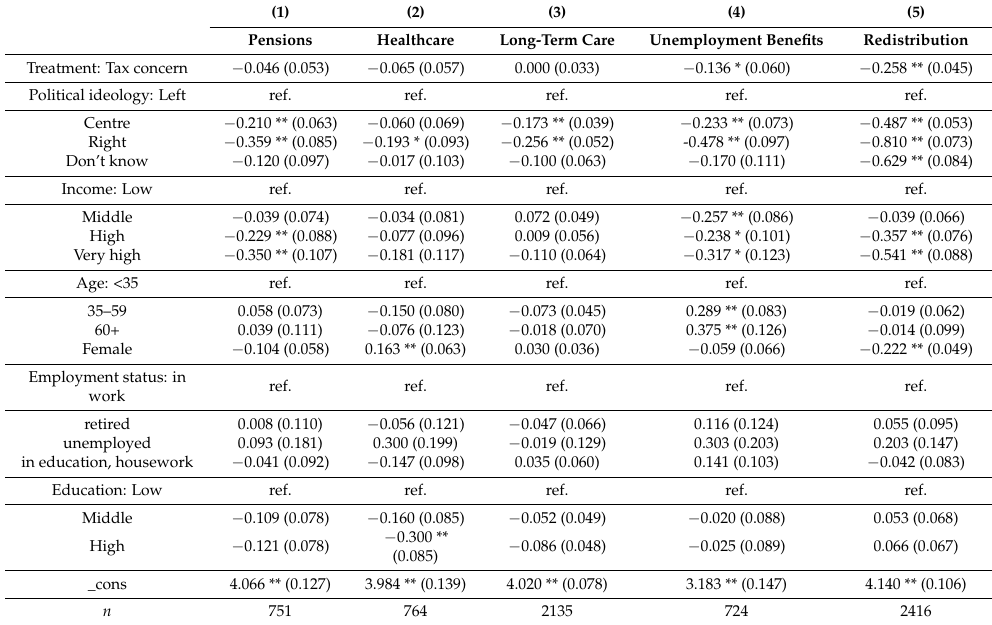
Table 2. Spending preferences and support for redistribution - individual level